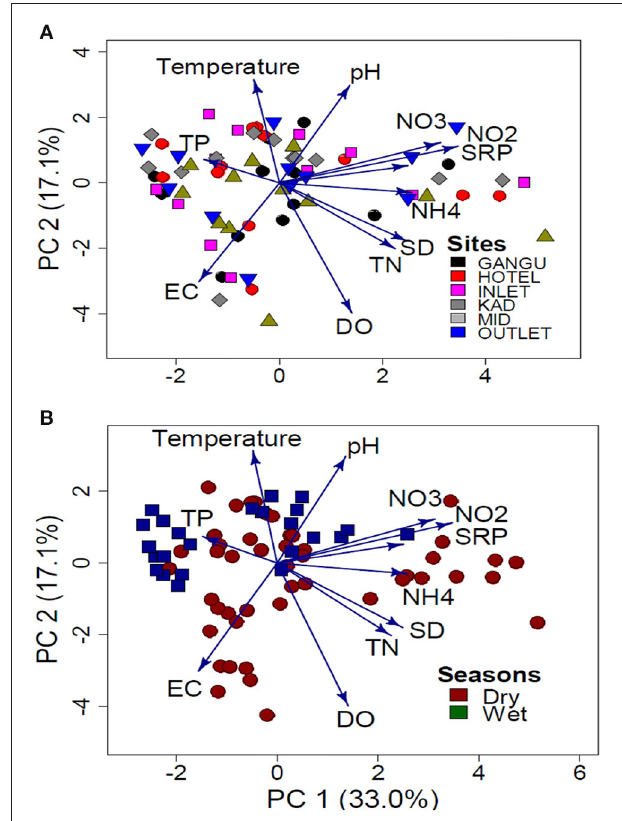
FIGURE 2 | PCA comparison of physico-chemical variables in Lake Kanyaboli based on: (A) site (B) season from February 2020 to February 2021. KAD, Kadenge; MID, Open